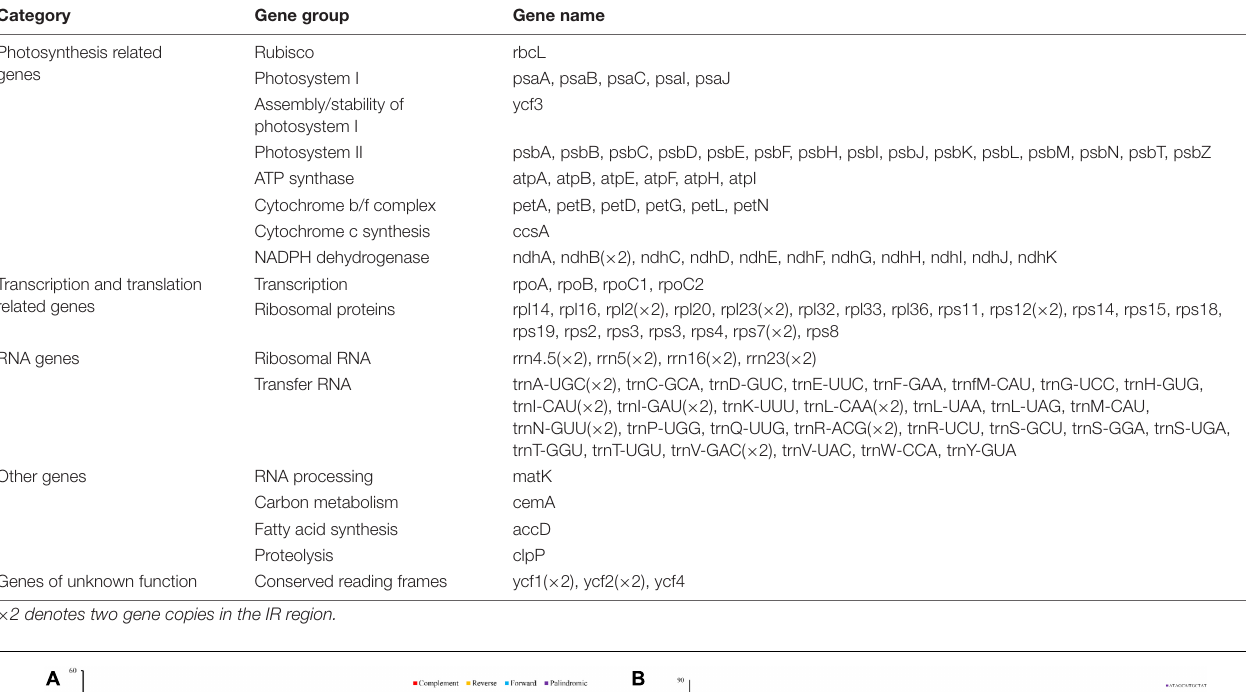
TABLE 2 | List of the annotated genes in the plastomes of the selected Arachis accessions. Category Gene group Gene name